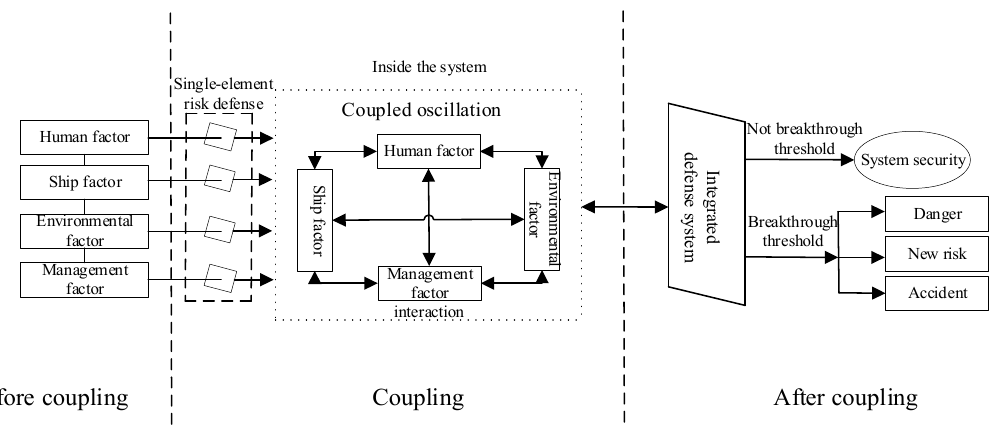
Figure 10. Coupling triggering process of the risk factors of maritime accidents.